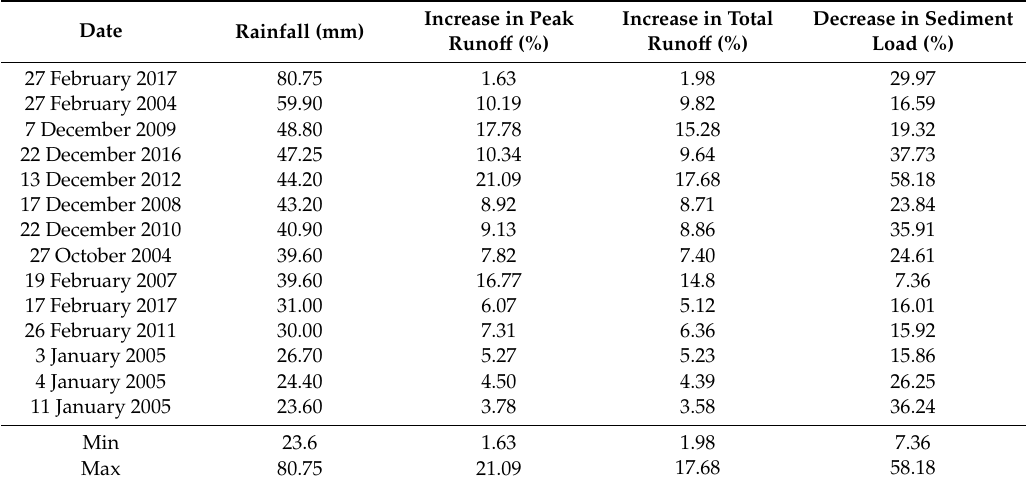
Table 7. Rainfall and simulated increases in peak and total discharge volume at the outlet under current and scenario (hotspot paving) conditions for the 14 largest storm